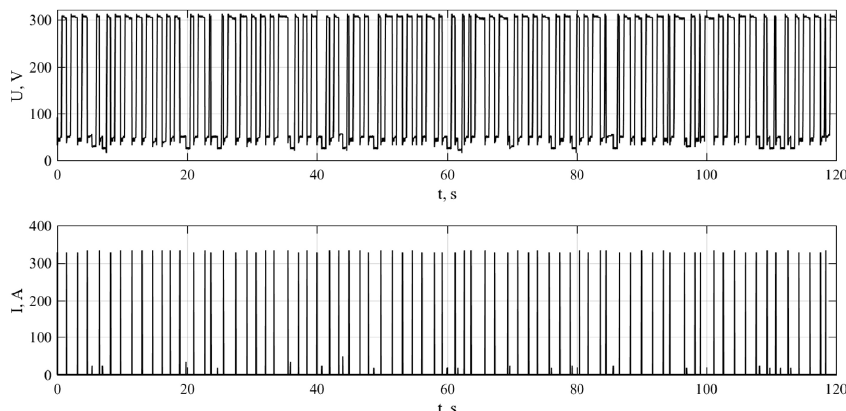
Figure 7. Oscillogram of impulses at a voltage of 200 V.